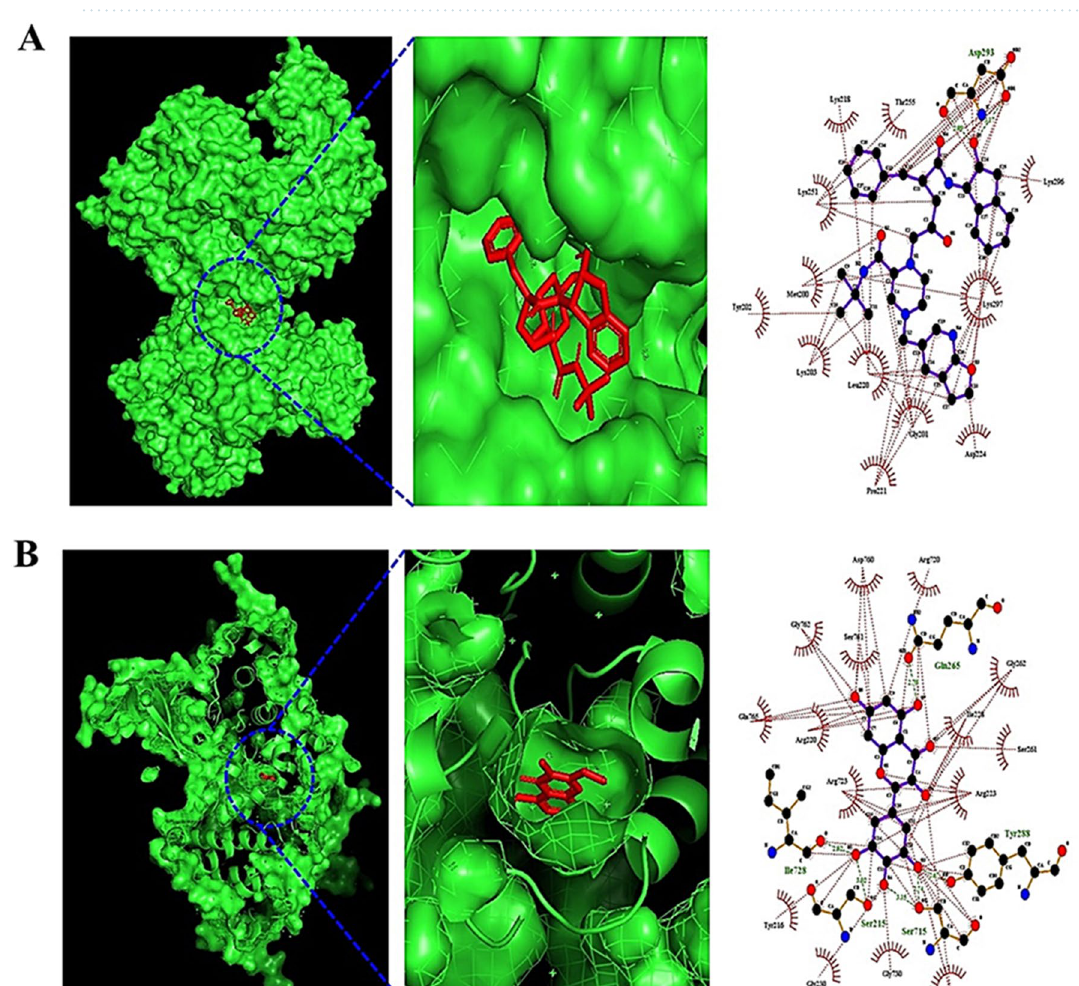
Figure 4. The molecular docking test on key targets of Wnt signaling pathway. ( A ) compound K-MAPK8 (PDB ID: 4YRB). ( B ) myricetin-GSK3B (PDB ID: